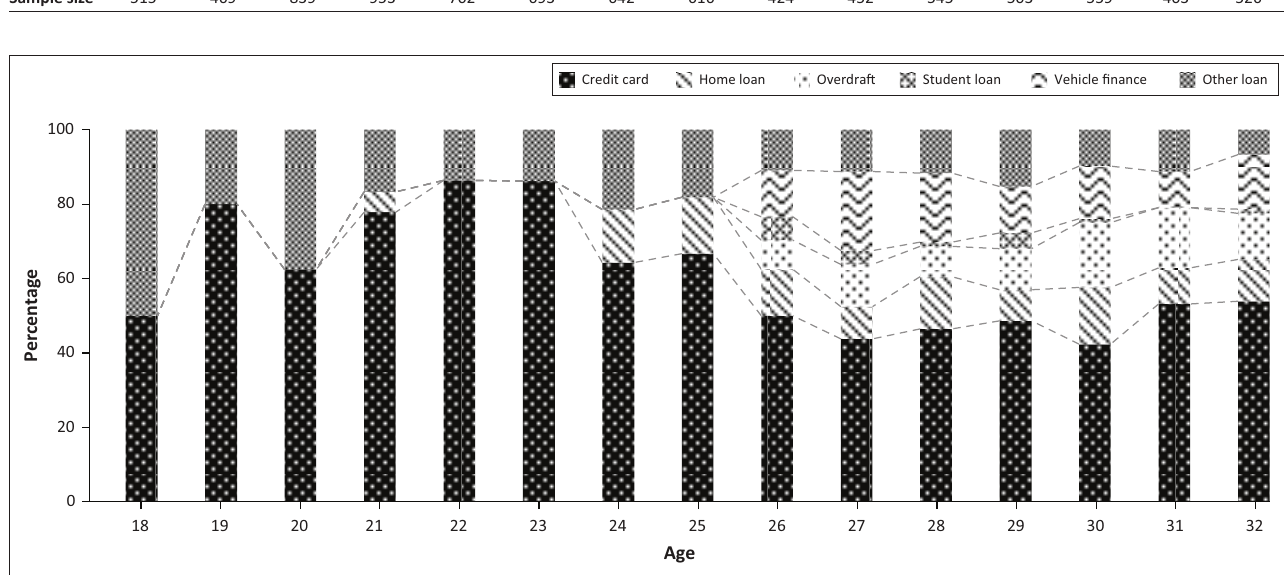
FIGURE 3: Overall debt usage breakdown of the